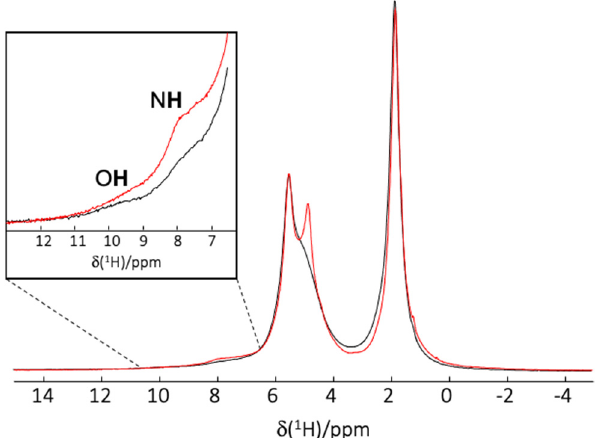
Figure 5. 1 H MAS NMR spectra of VCM-loaded PLGA 15 C NPs prepared in H 2 O (black spectrum) and in D 2 O by using deuterated VCM (red spectrum). An expansion on OH and NH of VCM is shown in insert.